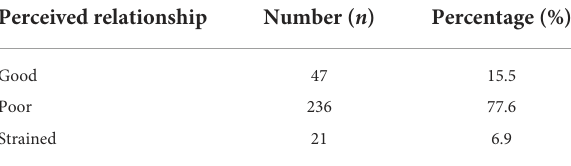
TABLE 5 Physicians’ preferences for shared